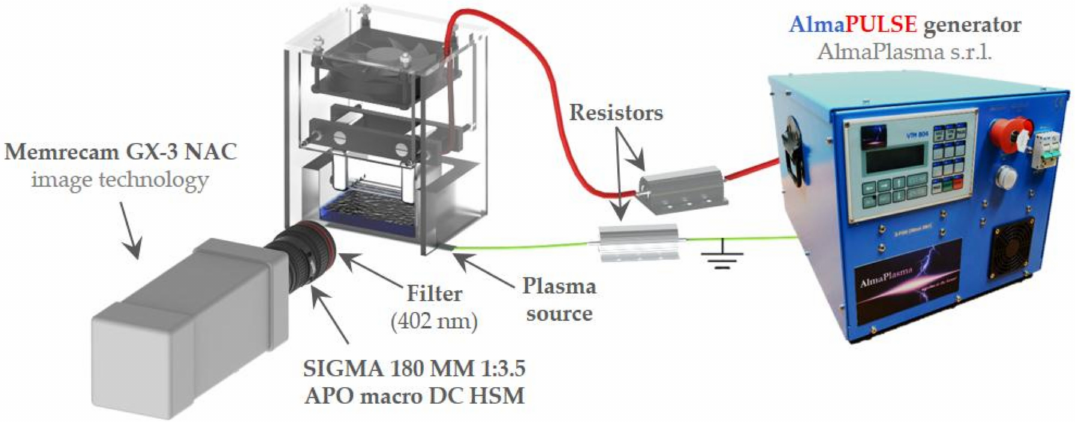
Figure 8. High-speed filter imaging